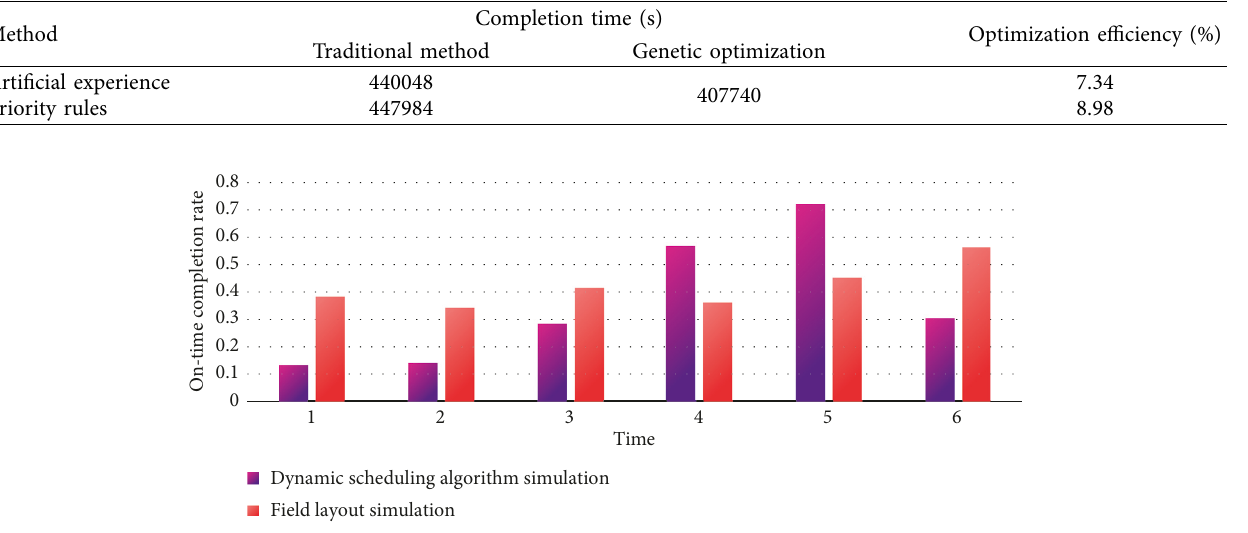
Table 5: Comparison before and after workshop optimization.